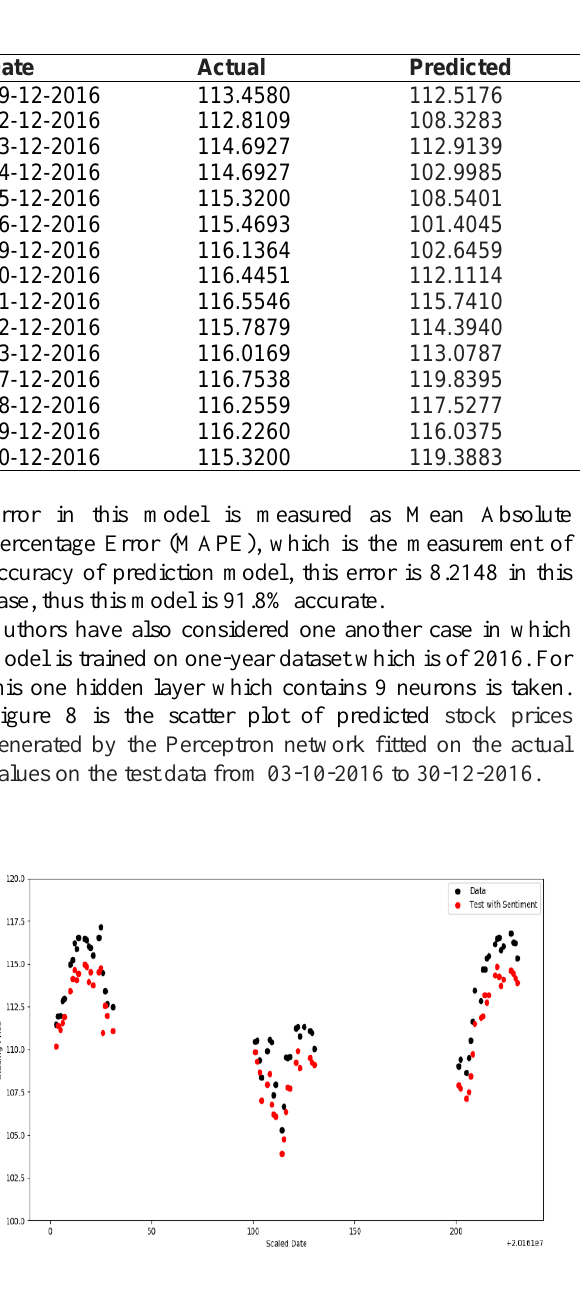
Table 9. Last 15 Actual and predicted values of the period 04-01-2016 to 30-12-2016